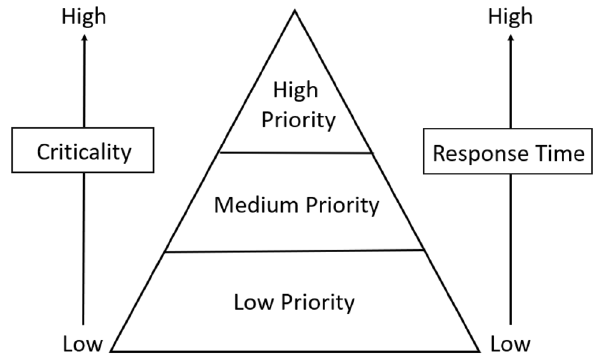
Fig. 2 Alarms priority based on criticality and time responses